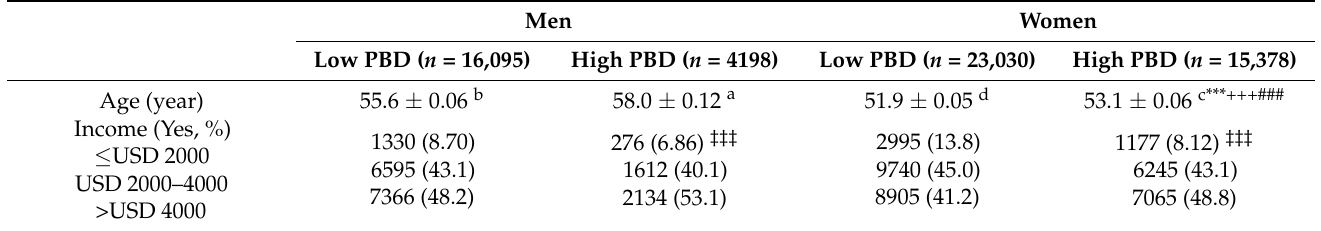
Table 2. Demographic characteristics and lifestyles according to plant-based diet (PBD) intake status and